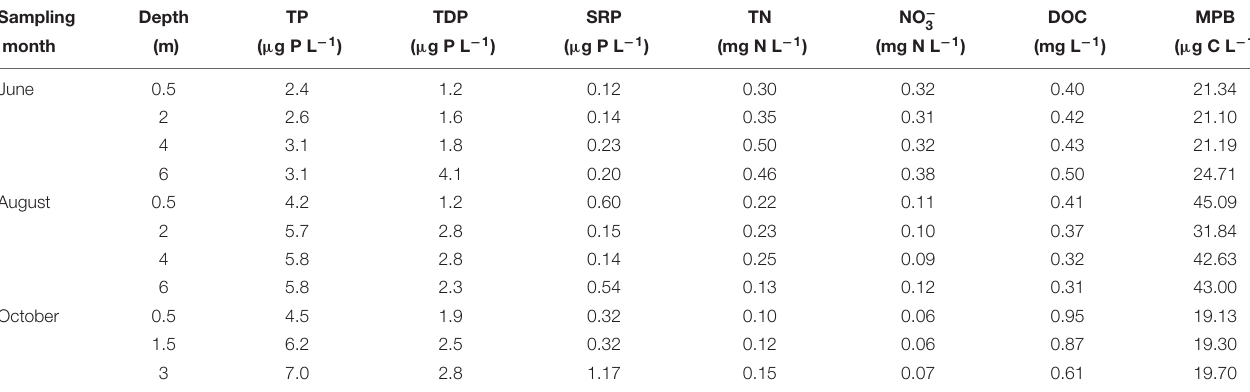
TABLE 1 | Physicochemical and biological properties of the water column from La Caldera lake (Sierra Nevada, Spain). Sampling